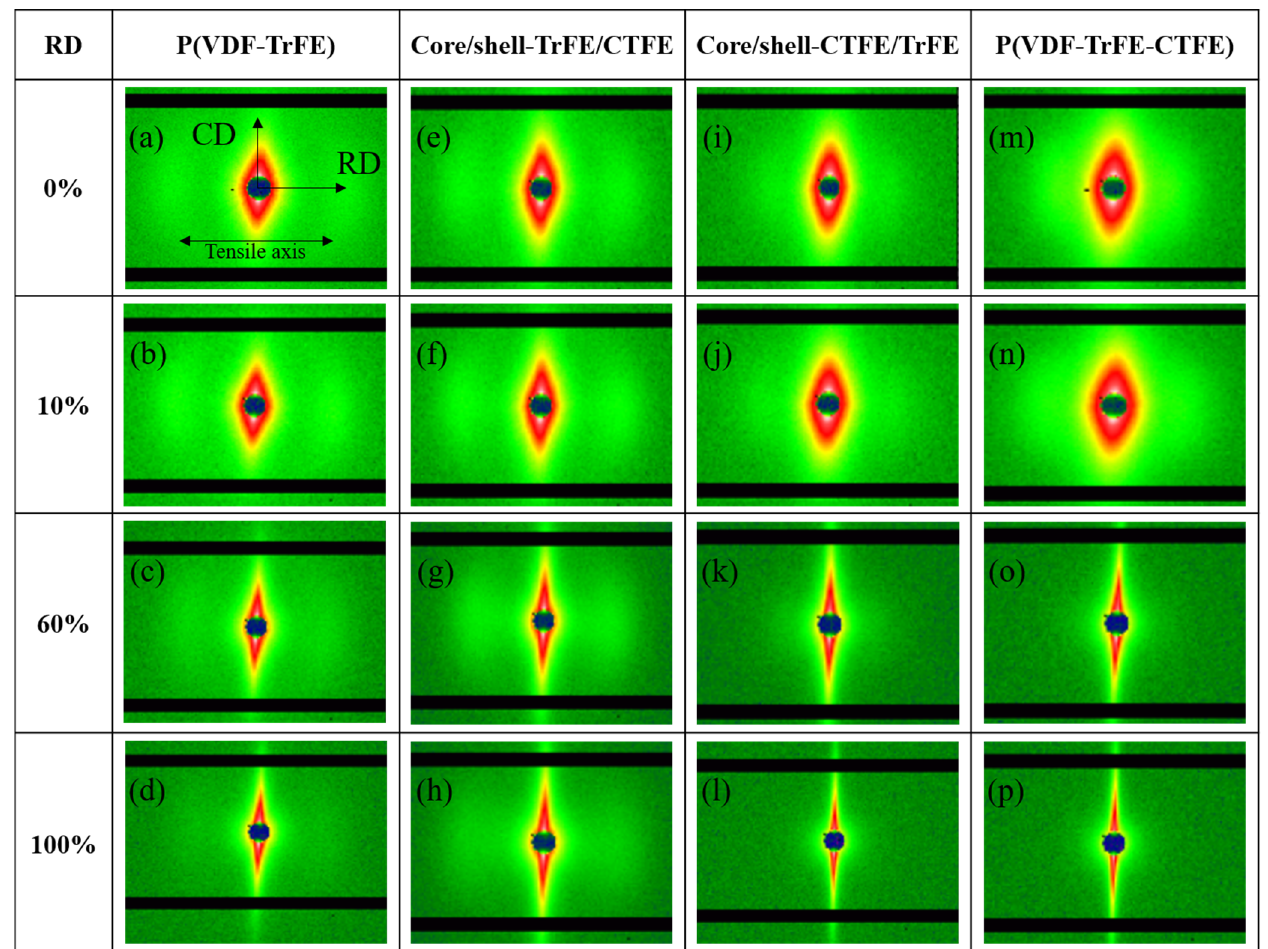
Figure 2. 2D SAXS patterns in the single and coaxial electrospun membranes at the designated strains in RD. ( a ), ( e ), ( i ), and ( m ) Nanofibers are oriented in a preferred orientation along the tensile axis, indicated by an elliptical shape of the diffraction pattern. ( b ), ( f ), ( j ), and ( n ) Nanofibers are further aligned to the tensile axis, indicated by a narrower elliptical shape of the diffraction pattern. ( c ), ( g ), ( k ), and ( o ) Most of the nanofibers are aligned to the tensile axis, indicated by a slim elliptical shape of the diffraction pattern. ( d ), ( h ), ( l ), and ( p ) Nanofibers are completely aligned to the tensile axis, indicated by a streak shape of the diffraction pattern.